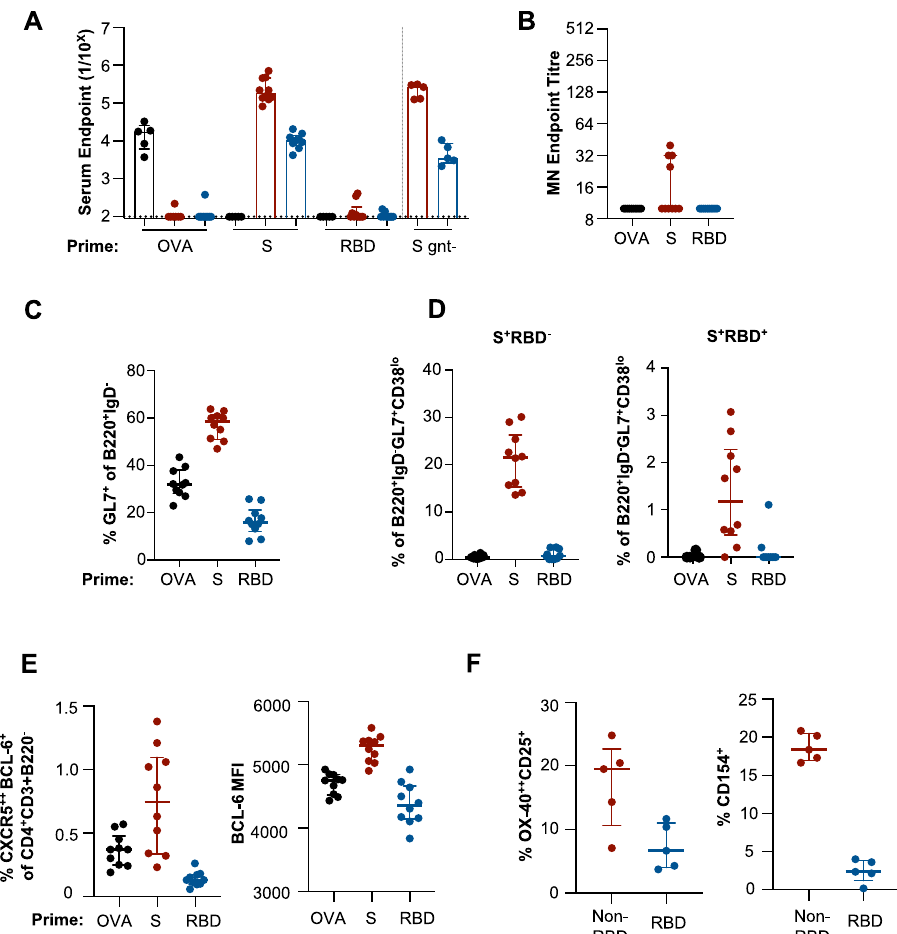
Fig. 1 Primary immunogenicity of SARS-CoV-2 subunit proteins in C57BL/6 mice. Mice were immunised intramuscularly with S, RBD or OVA proteins and immune responses assessed 14 days post immunisation ( n = 10 animals across two independent experiments, S gnt- n = 5). A Reciprocal serum endpoint dilutions of S- (red; n = 10), RBD- (blue; n = 10) or OVA-speci fi c IgG (black; n = 5) were measured by ELISA. Dotted lines denote the detection cut off (1:100 dilution). B Serum neutralisation activity was assessed using a microneutralisation assay. C Draining lymph node germinal centre activity assessed by GL7 expression in B220 + IgD − B cells. D Frequency of germinal centre B cells (B220 + IgD − GL7 + CD38 lo ) speci fi c for Spike (S + RBD − ) or RBD (S + RBD + ) probes. E Frequency of TFH cells (CXCR5 ++ BCL-6 + CD4 + CD3 + B220 − ) and corresponding median fl uorescent intensity of BCL-6. F Antigen- speci fi c TFH cells were identi fi ed as either OX-40 ++ CD25 + or CD154 + following 18 h of stimulation with S (minus RBD) or RBD peptide pools ( n = 5 animals). Antigen-speci fi c responses are presented after background subtraction using a DMSO control. Data is presented as median ± IQR. Source data are provided as a source data fi This was also evidently using a blocking ELISA approach, where immunogenicity, the small antigenic target of the RBD remains S-R immunised animals displayed a markedly higher proportion attractive for focusing immunity upon protective neutralising of RBD-speci fi c antibodies compared to S-S immunised animals epitopes. However, the recent identi fi cation of the N-terminal (Fig. S9). Inhibition of ACE2-RBD interaction by serum anti- domain (NTD) 19 and other alternative S-localised protective epitopes 20,21 highlights additional antibody targets for vaccine bodies was similarly enhanced in the S-R group compared to the protection. To assess the relative merits of RBD-focussed anti- S-S group (Figs. 2B and S8). Selective RBD focussing translated body responses versus more holistically targeting the entire S, we into increased serum neutralisation, with S-R eliciting 2.5-fold primed C57BL/6 mice with S or RBD, and then boosted 21 days higher activity (median 361; IQR 226 – 706) compared to S-S (143; later with either homologous or heterologous immunogens. IQR 96 – 254) ( p = 0.0055) (Fig. 2C). Neither R-R nor R-S Homologous S prime-boost (S-S) elicited high reciprocal serum immunisation reliably induced signi fi cant serum neutralising endpoint titres of both S- (median 2.77 × 10 6 ; IQR 1.71 – 3.62) and activity, although they elicited modest levels of antibodies that RBD-speci fi c antibodies (2.28 × 10 6 ; IQR 1.23 – 3.17) (Fig. 2A). In block ACE2-RBD engagement. The capacity of S-S and S-R contrast to a single RBD dose, we found that homologous RBD immunisation to elicit potent binding and neutralising responses prime-boost (R-R) immunisation was capable of eliciting modest in C57BL/6 mice was mirrored in BALB/c mice (Fig. S10). serum titres of S- and RBD-speci fi c antibodies, suggestive of The pro fi le of B and T cell immunity was assessed in draining memory B cells elicited after the RBD-prime. RBD prime-S boost lymph nodes 2 weeks after the boost immunisation. R-R elicited (R-S) induced similarly modest titres. However, we fi nd RBD the lowest GC B-cell responses measured by surface GL7 + expression (22.3%; IQR 20.5 – 31.6) (Fig. 2D). Both S-S (GL7 + : boosting of S-primed animals (S-R) markedly increased RBD- 47.8%, IQR 44.3 – 62.3) and S-R (GL7 + : 52.7%; IQR 49.7 – 54.5) speci fi c serum antibody titres 4.2-fold relative to S-S ( p = 0.0055).